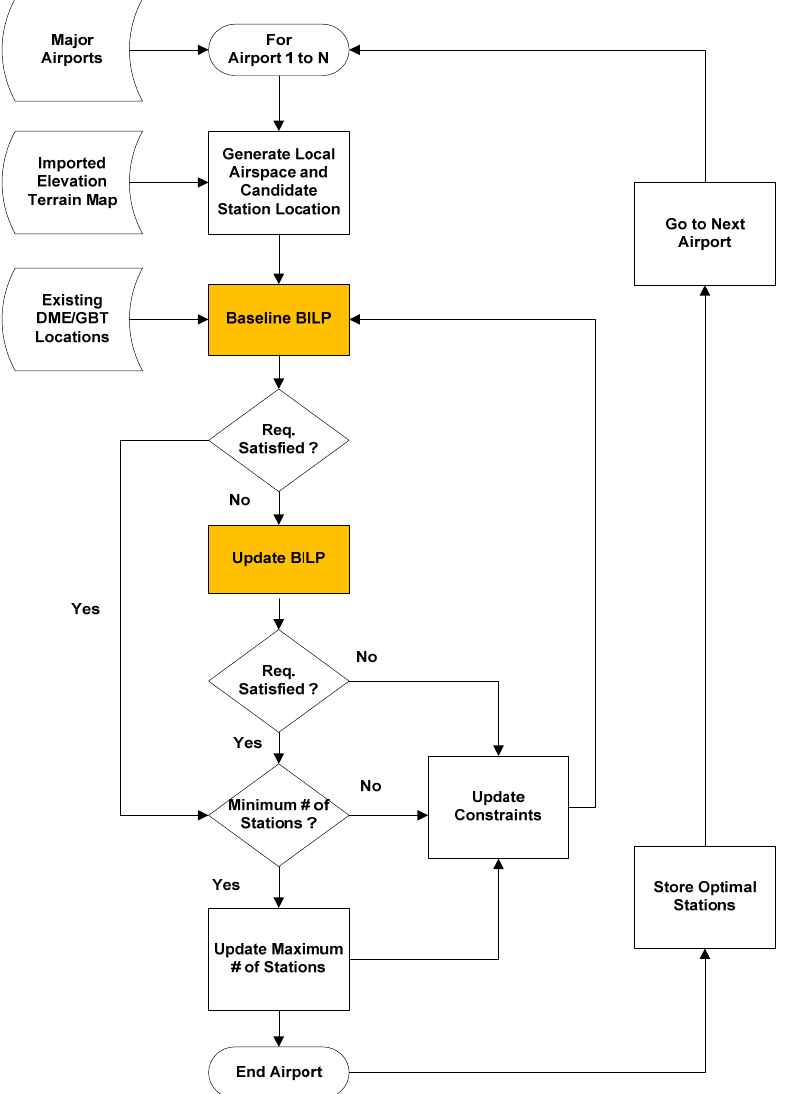
Figure 6. Overall coverage analysis methodology process.